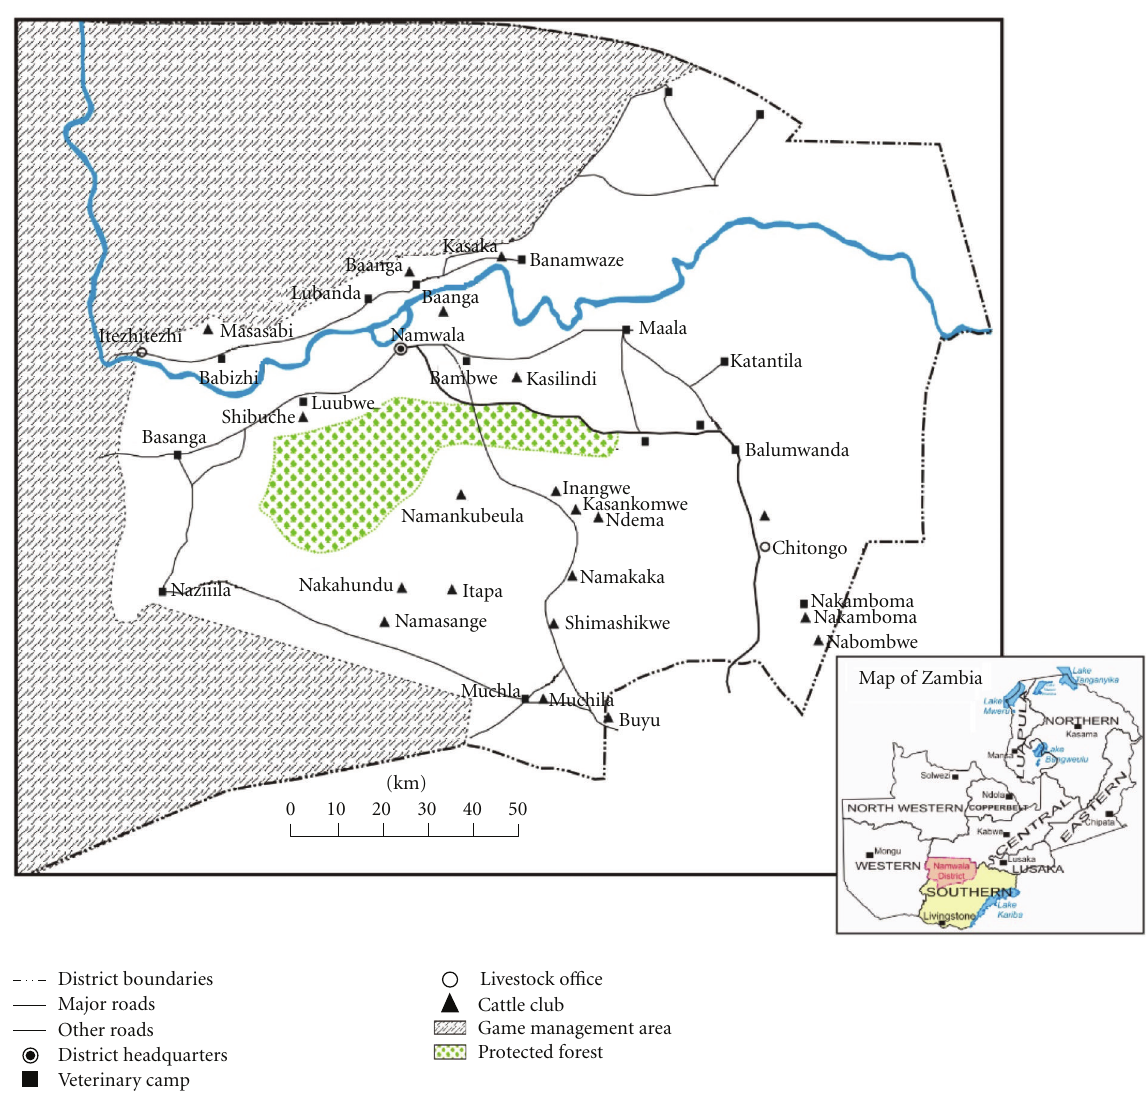
Figure 2: The graph indicates correlation of tuberculosis and fasciola condemned organs to area of origin. Note that at slaughter, animals with high fluke condemnation rate corresponded to those for tuberculosis by area of